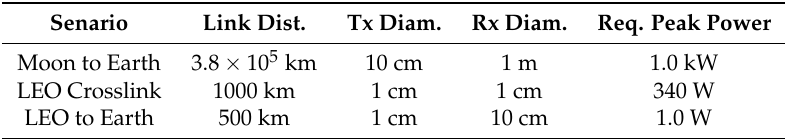
Table 1. The required peak powers for the MOCT link scenarios for select transmitter (Tx) and receiver (Rx) diameters. Senario Link Dist. Tx Diam. Rx Diam.